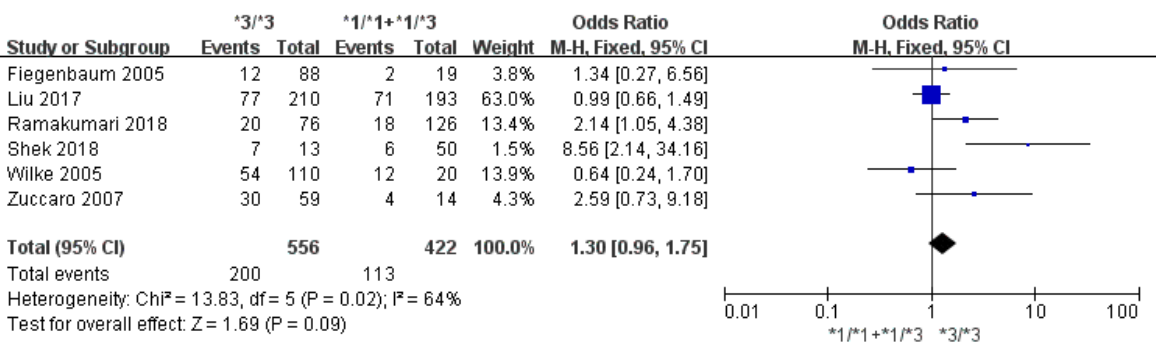
Figure 3. Forest plots of the association between CYP3A5*3 and statin-induced myopathy.